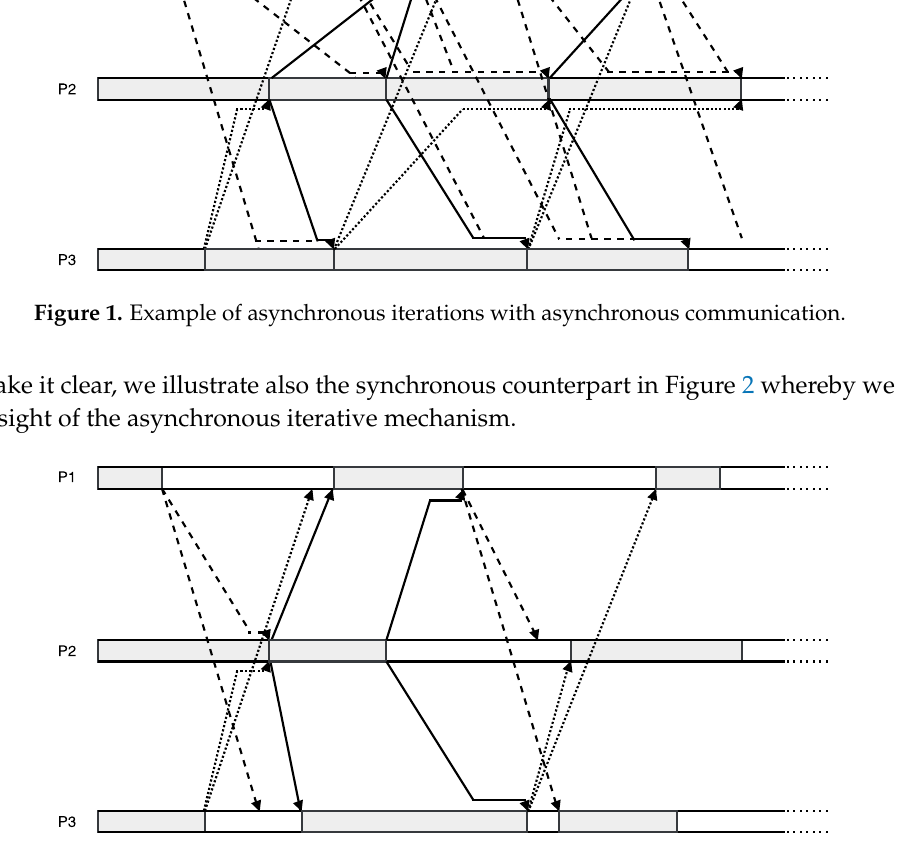
Figure 2. Example of synchronous iterations with asynchronous